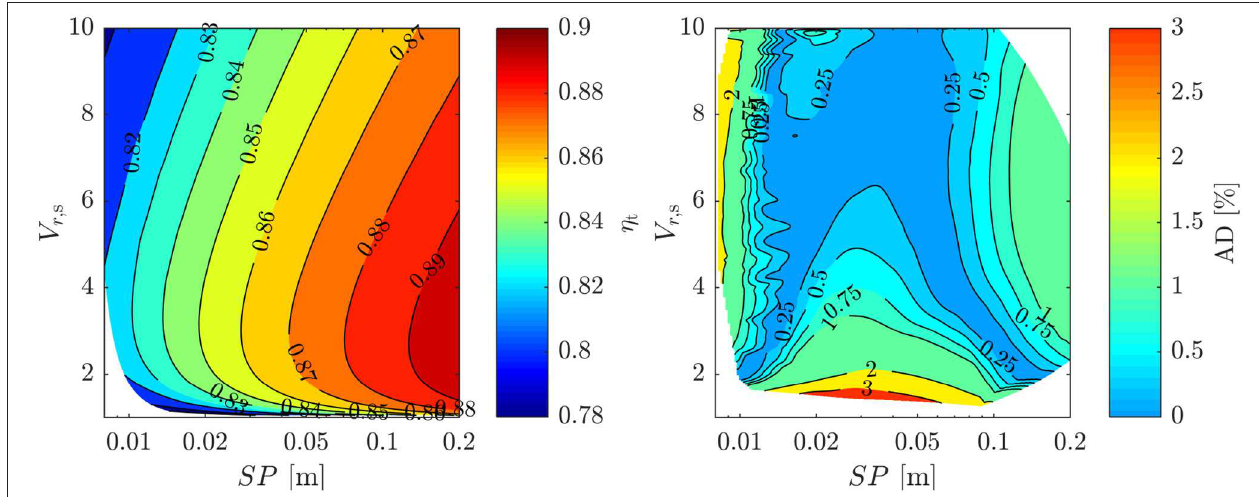
FIGURE 4 | Turbine efficiency map defined by the parameters defined in Table 1 (left) , and absolute deviation (AD) between this derived map and the original map in % (right) .